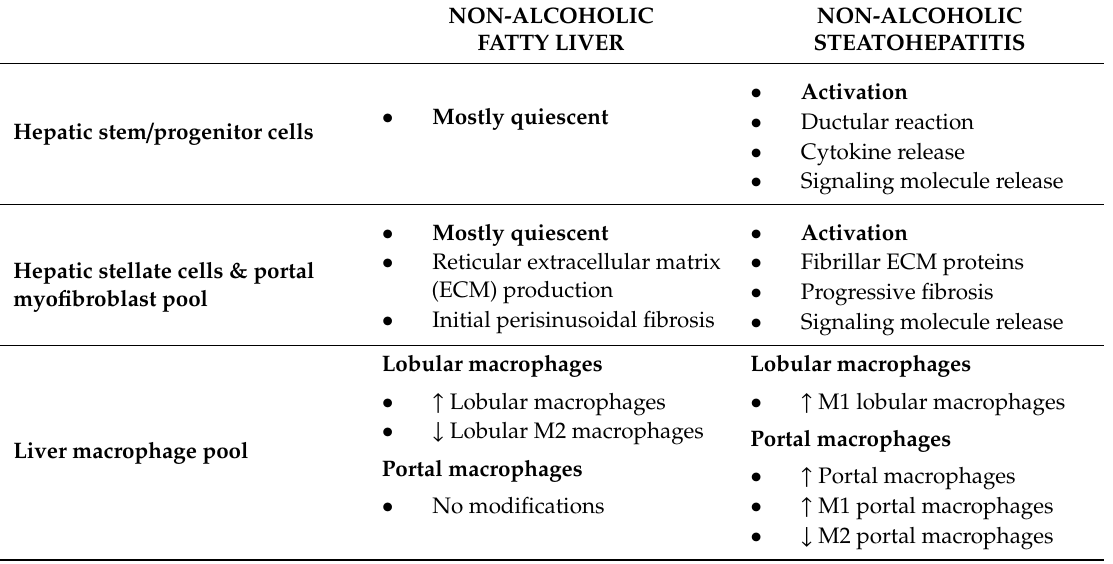
Table 2. Phenotypical changes within Hepatic Stem / progenitor Cell niche in